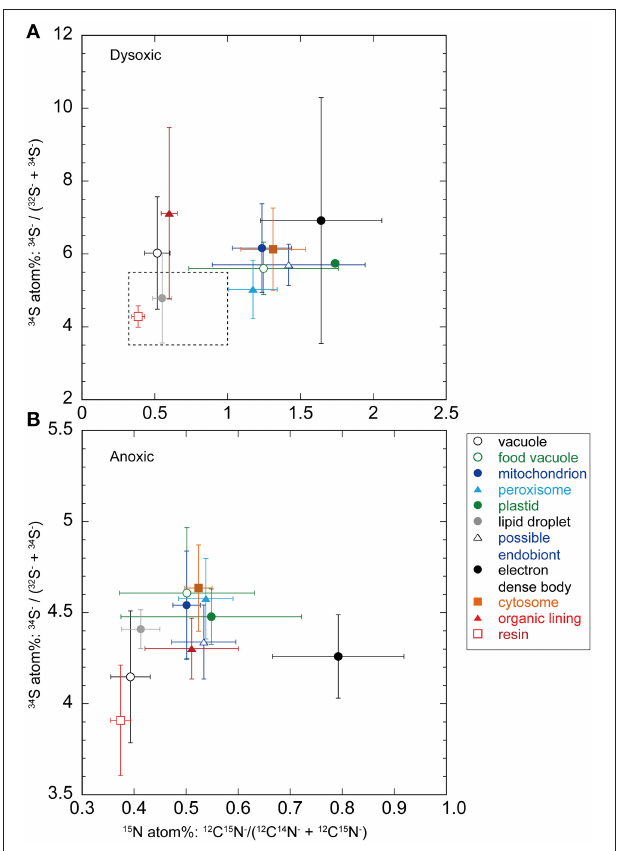
FIGURE 3 | Averaged ( ± SD) nitrogen and sulfur isotopic compositions (in atomic %) of organelles and ultrastructural features from foraminiferal semi-thin sections (A, dysoxic specimens; B, anoxic specimens). Note different scales on both sets of axes. The dotted box in a corresponds to the same scale that shown in (B)